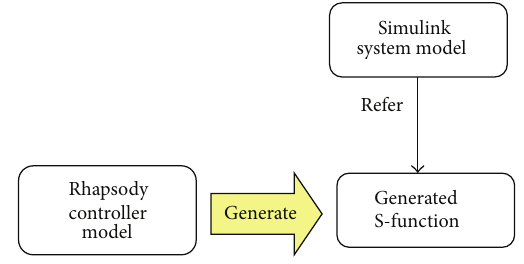
Figure 2: Generating an